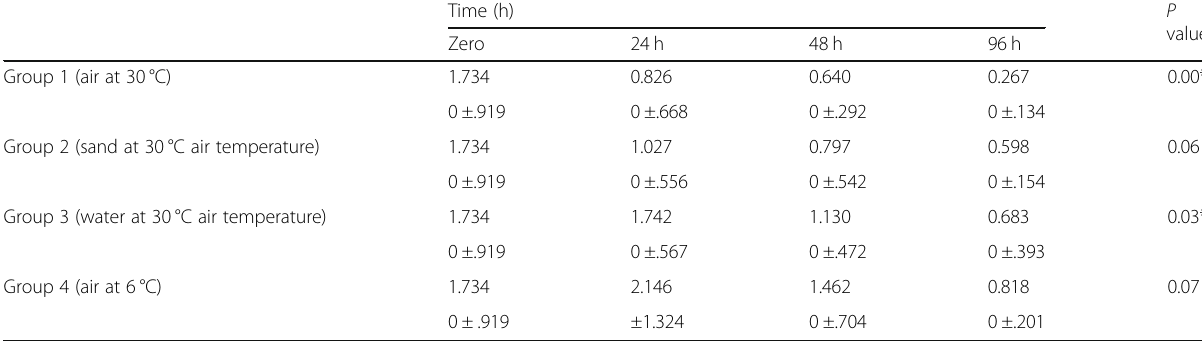
Table 2 Comparison of the mean skin GAPDH levels at different postmortem time points in the studied groups Time (h)